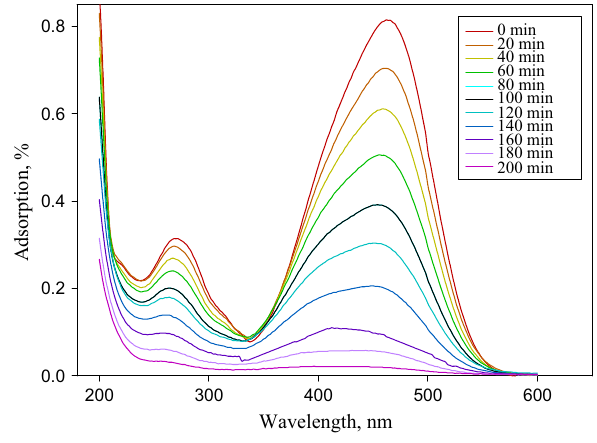
Fig. 5 Adsorption spectrum of reaction system at presence of ZnO photocatalyst for 200 mg L −1 photocatalyst, methyl orange 10 mg L −1 and pH